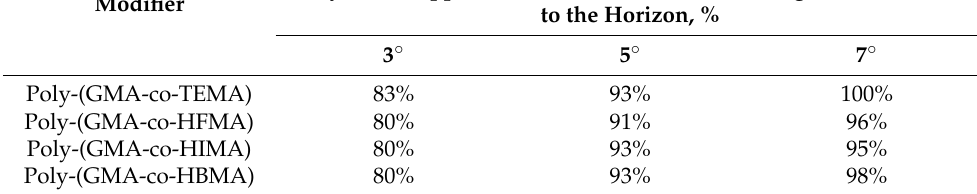
Table 6. Percentage of water droplets rolling off the aluminum surface modified with GMA- and FMA-based copolymers with a theoretical FMA content of 66.7% when the drops are dropped onto a plane with a fixed angle of inclination to the horizon. Percentage of Spontaneous rolling off of Water Droplets When They Are Dropped Onto a Plane with a Given Angle of Inclination Modifier to the Horizon,